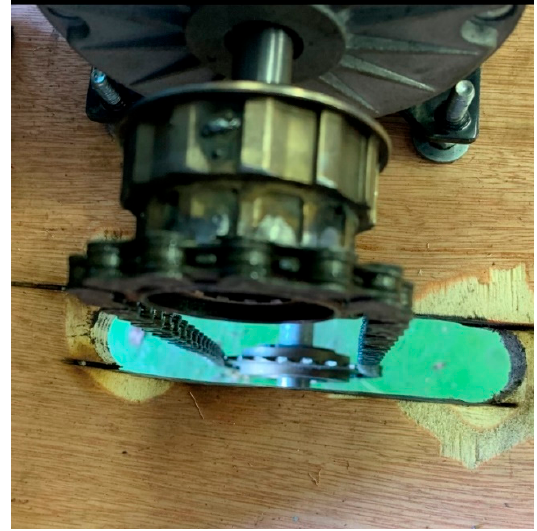
Figure 14. Slot for chain to motor.